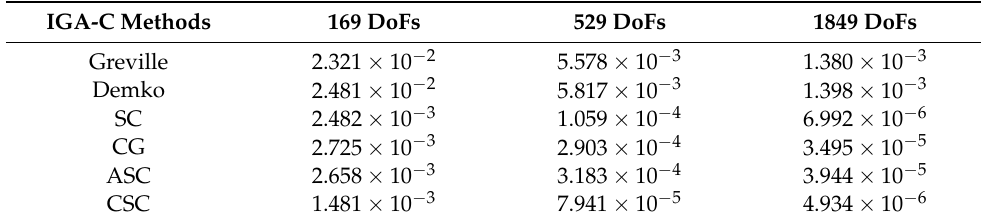
Table 2. Relative errors in L 2 norm of IGA-C with different collocation schemes after twice h − refinements ( p = 3).